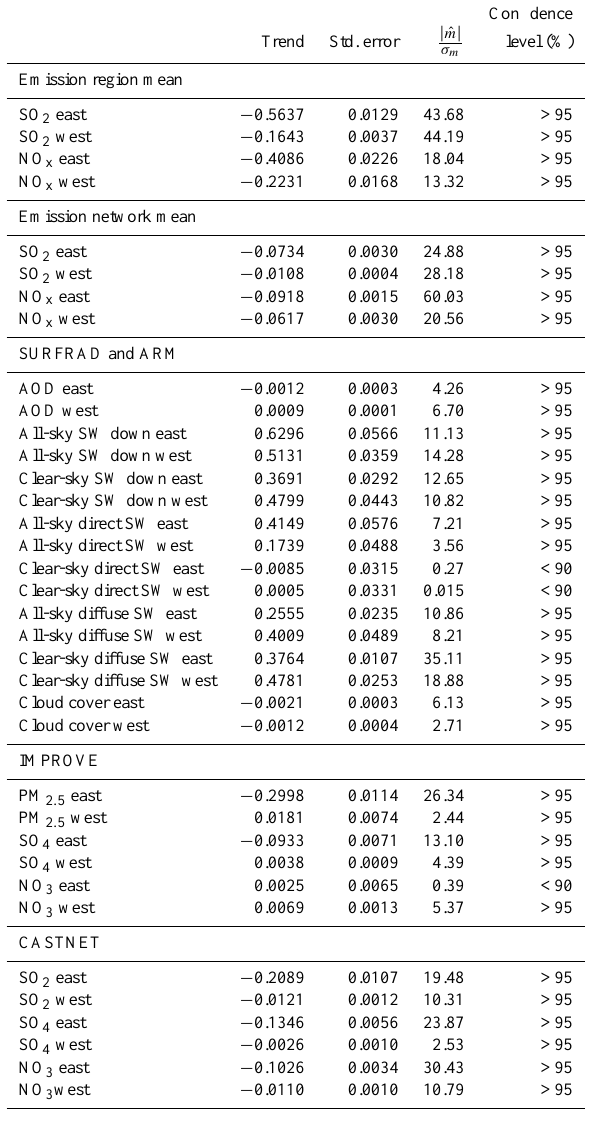
Table 2. Trends (slope) for each data set between periods of 1995 to 2010, along with the standard error and confidence level, respec- tively.